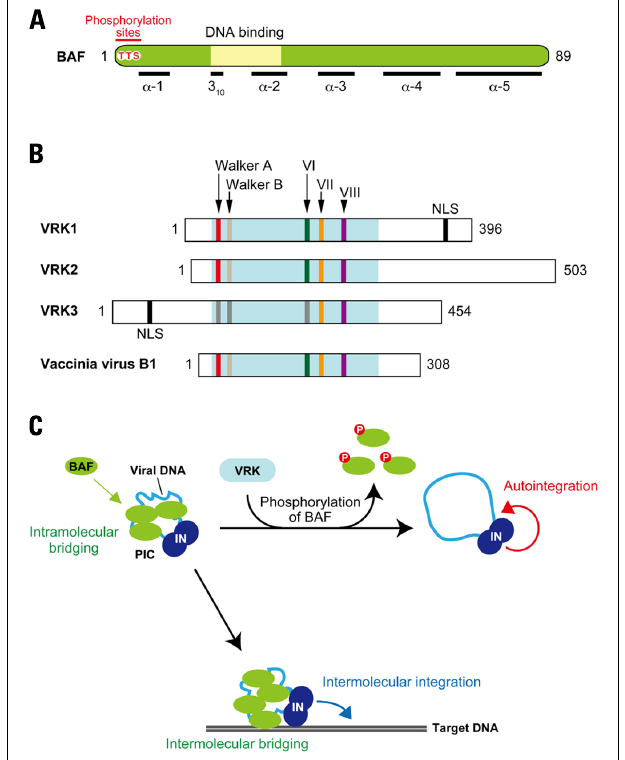
FIGURE 5 | Disruption of the retroviral PIC by phosphorylation of BAF. (A) Features of BAF. BAF is highly conserved among multicellular eukaryotes, and 86 out of 89 amino acid residues are identical between humans and mice.This protein is composed of five helices ( α -1 to -5) and a 3 10 -helical turn, and DNA-binding activity of BAF is thought to be attributed to the HhH motif. N-terminal threonine (T) and serine (S) residues (Thr-2, Thu-3, and Ser-4) indicated in red are reported as phosphorylation sites of BAF. (B) VRK family proteins. Domain organization of mouseVRKs and their vaccinia viral homolog, B1 kinase, are shown. All theVRK/B1 family proteins contain highly conserved enzymatic domain involved in the phosphotransfer reaction, which is consists of the ATP binding motifs (Walker A andWalker B), catalytic domain (subdomainVI), active site (subdomainVII), and substrate recognition domain (subdomainVIII). However, some substitutions in several residues are found inWalker A, Walker B, and subdomainVI ofVRK3, which may affect kinase activity of this ortholog. Additionally,VRK1 andVRK3 possess putative NLS at the C-terminal and N-terminal portions, respectively. (C) Reciprocal regulation of PIC integration activity by BAF andVRK. As the viral double-stranded DNA is synthesized by reverse transcription, BAF is recruited into the PIC in cytoplasm through direct binding with viral DNA. Once BAF is incorporated into the PIC, viral DNA is intramolecularly bridged by BAF’s dimerization and DNA-binding activities.This intramolecular bridging by BAF compacts the viral DNA, making it less accessible as a target for autointegration. In addition, PIC associated BAF also anchors to the target DNA by its DNA bridging property (intermolecular bridging), thereby stimulating the intermolecular integration activity of the PIC. On the other hand,VRK is able to induce release of BAF from the PIC via phosphorylation of BAF. By the dissociation of BAF, viral DNA may adopt a more open structure, resulting in its increased availability for